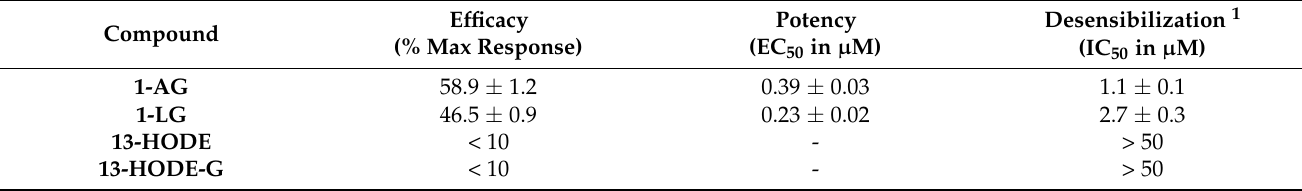
Table 5. Effect of 13-HODE-G and related compounds on human recombinant TRPV 1 -mediated intracellular calcium elevation. Results are shown as the mean ± SD. 1 Desensibilization was assayed using 100 nM